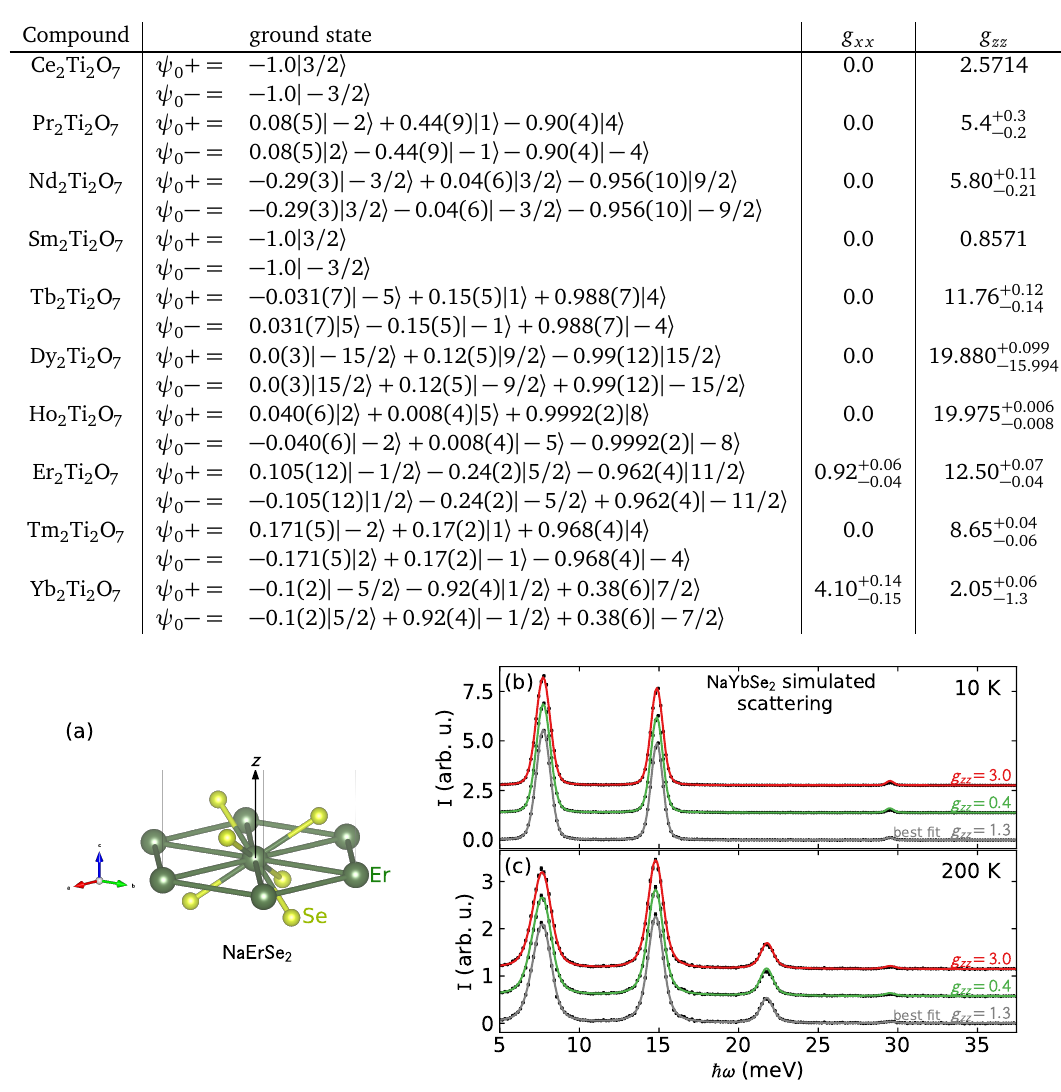
Figure 3: Delafossite NaYbSe simulated scattering and fits. (a) shows the crystal 2 structure of NaErSe , the basis for this fit, with a three-fold axis along the c axis, 2 which we set as z . (b) and (c) show the point-charge model simulated scattering with Yb 3 + as the central ion at 10 K and 200 K, respectively. The three curves show three fits: the bottom (grey) shows the original model and best fit, the middle (green) shows the minimum g to within ∆ χ 2 < 1, and the top (red) shows the maximum zz g to within ∆ χ 2 < zz